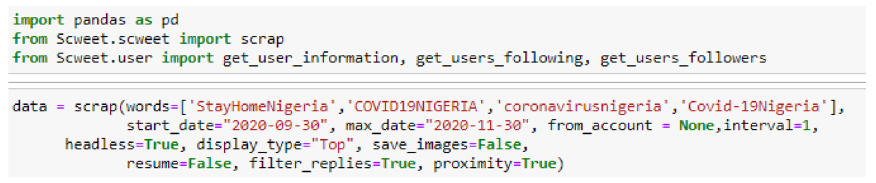
Fig. 2 Searching of tweets using python library by keywords or word